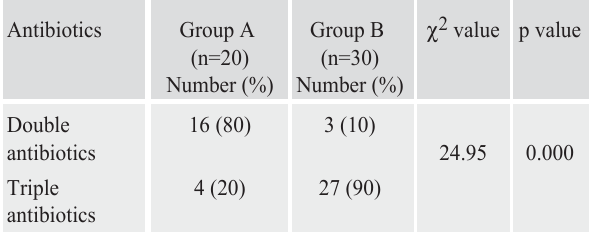
Table II: Length of hospital stay